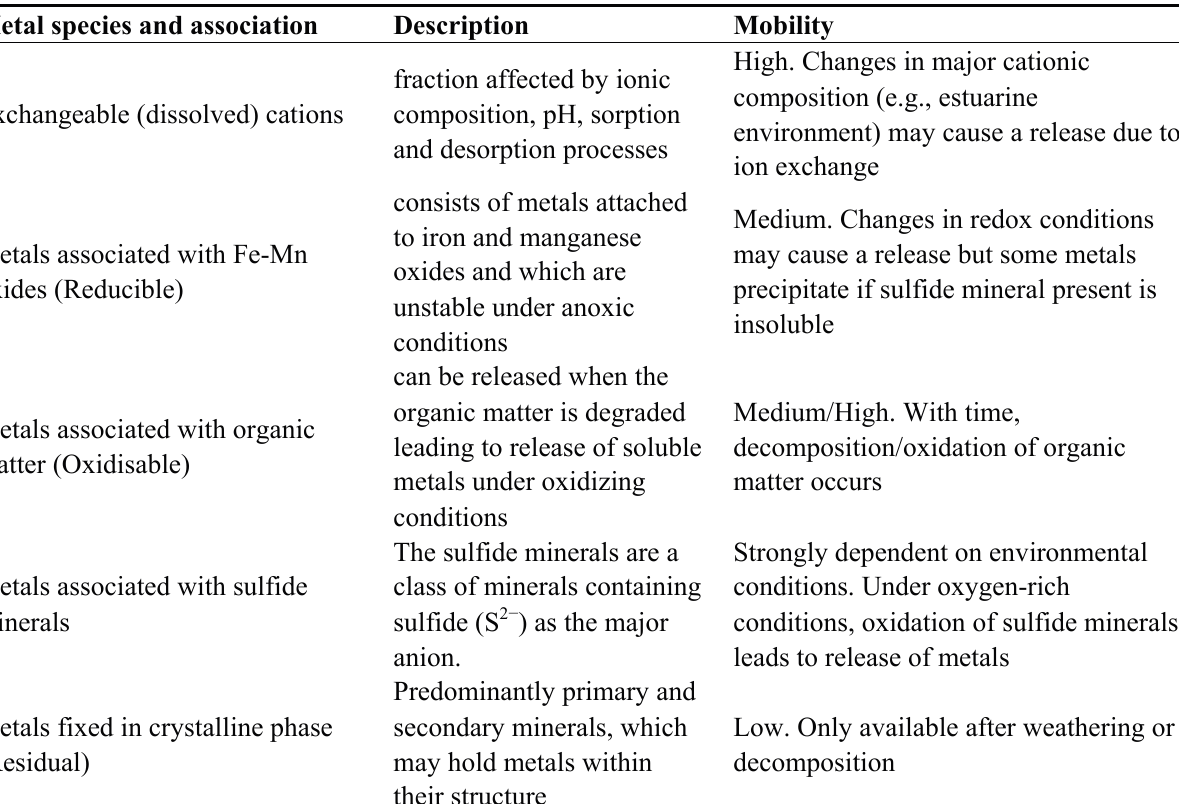
Table 8. Relative mobility and availability of trace metals (modified from David, 1995 and Tessier 1979